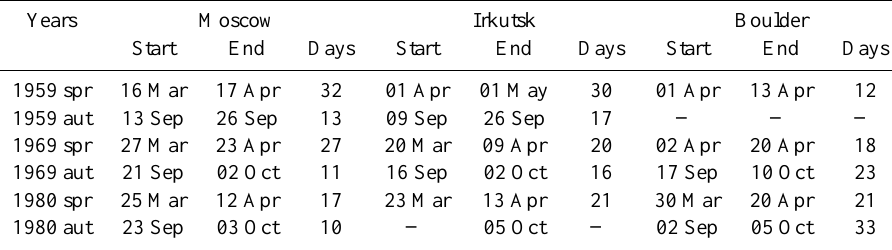
Table 3.2. Same as Table 3.1, but for solar maximum Years